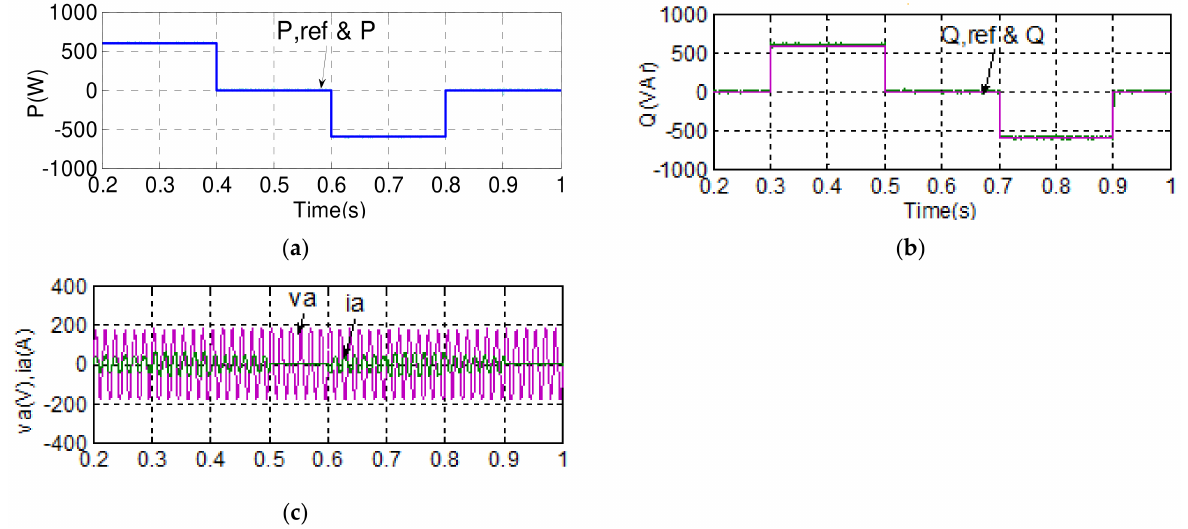
Figure 16. Simulated MG inverter waveforms in case 1: ( a ) active power and reference; ( b ) reactive power and reference; ( c ) phase-a voltage and current